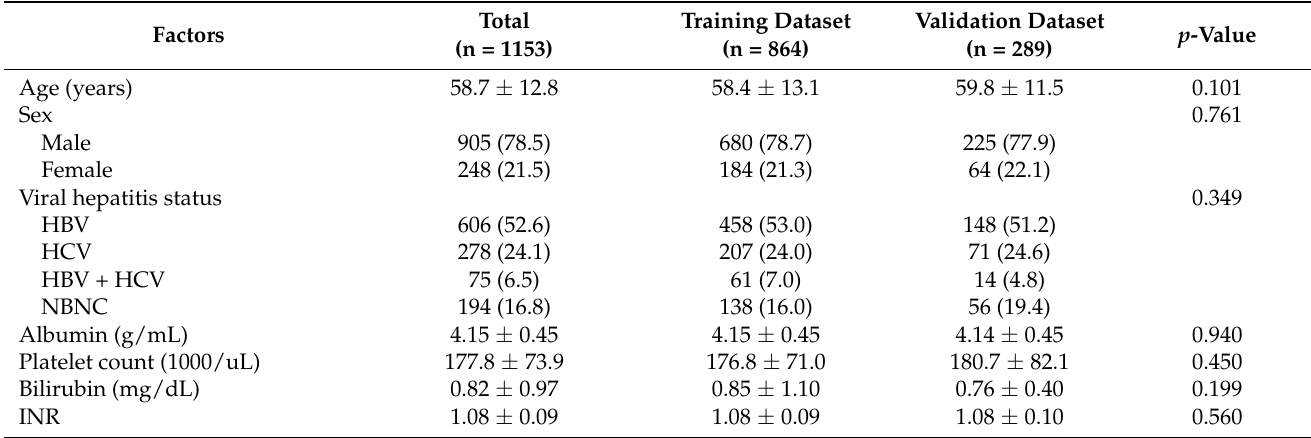
Table 1. Clinical characteristics of patients classified into training and validation datasets.